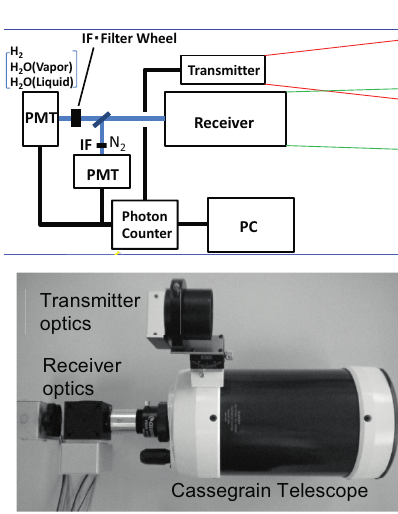
Fig.2 Atmosphere monitoring with nitrogen and water vapor echoes. (a)Nitrogen Raman echo (b)Water vapor Raman